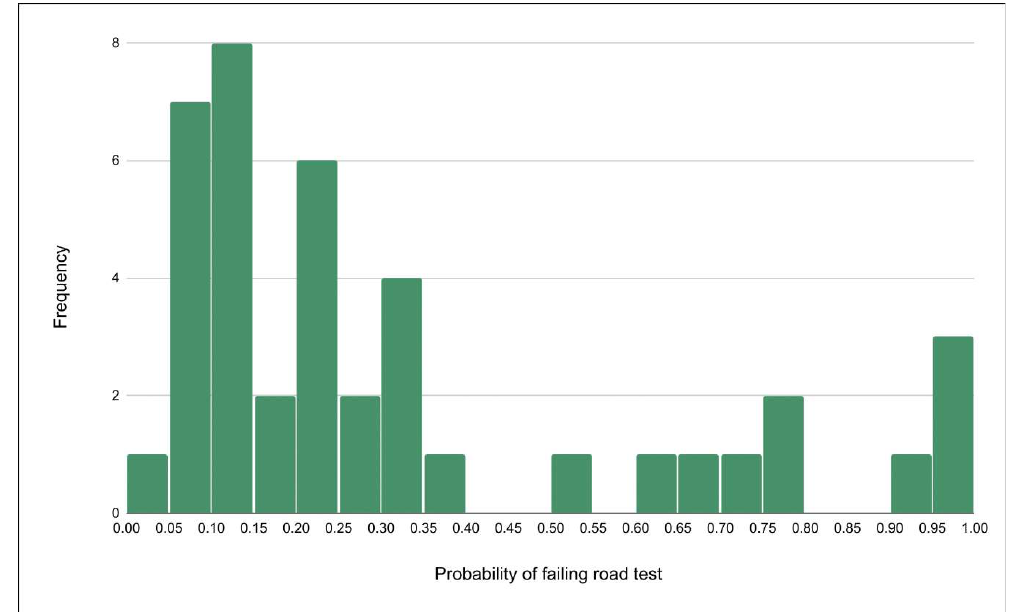
Figure 1. Histogram showing participants’ probability of failing a road-based driving test based on the fitness-to-drive (FTD) calculator for stroke patients. The FTD calculator utilizes psychometric testing scores (Trail Making Test Part A and Snellgrove Maze Task) and a stroke-specific algorithm to estimate the probability of failing the road test. While most participants had a higher probability to pass than fail a road test (scores below 50%), the bimodal distribution show potential to identify both low- (≤25%) and high-risk (≥70%) stroke patients on either end of the scale.